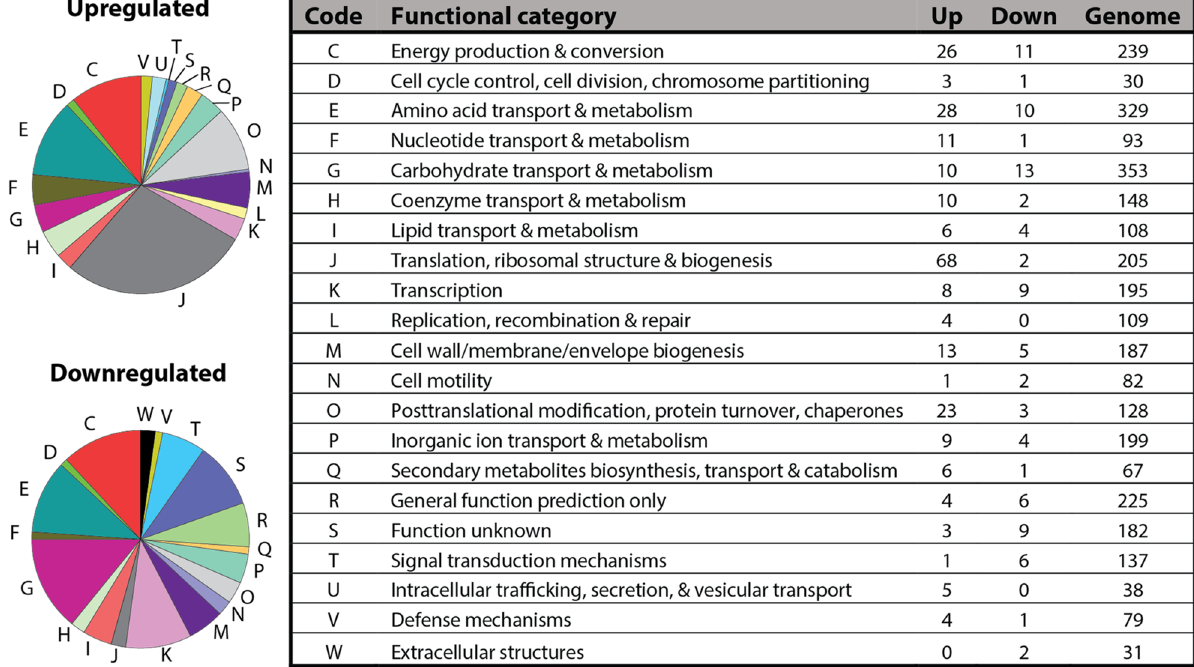
Figure 1. Cluster of Orthologous Genes (COGs). Changes in gene expression specific to ampicillin treatment are enriched in a few COG categories but are rare or nonexistent in others. Left: The number of genes (counts) that are differently expressed (adjusted p < 0.1) in the ampicillin treated population organized according to COGs (Top left: upregulated; Bottom left: downregulated). Only genes that were unique to the treated population (compared to stationary phase) were included; genes that show differential regulation in both the treated and untreated population (compared to stationary phase) were removed. Genes in multiple functional categories were accounted for more than once. Right: Functional categories and codes from REF 44 .